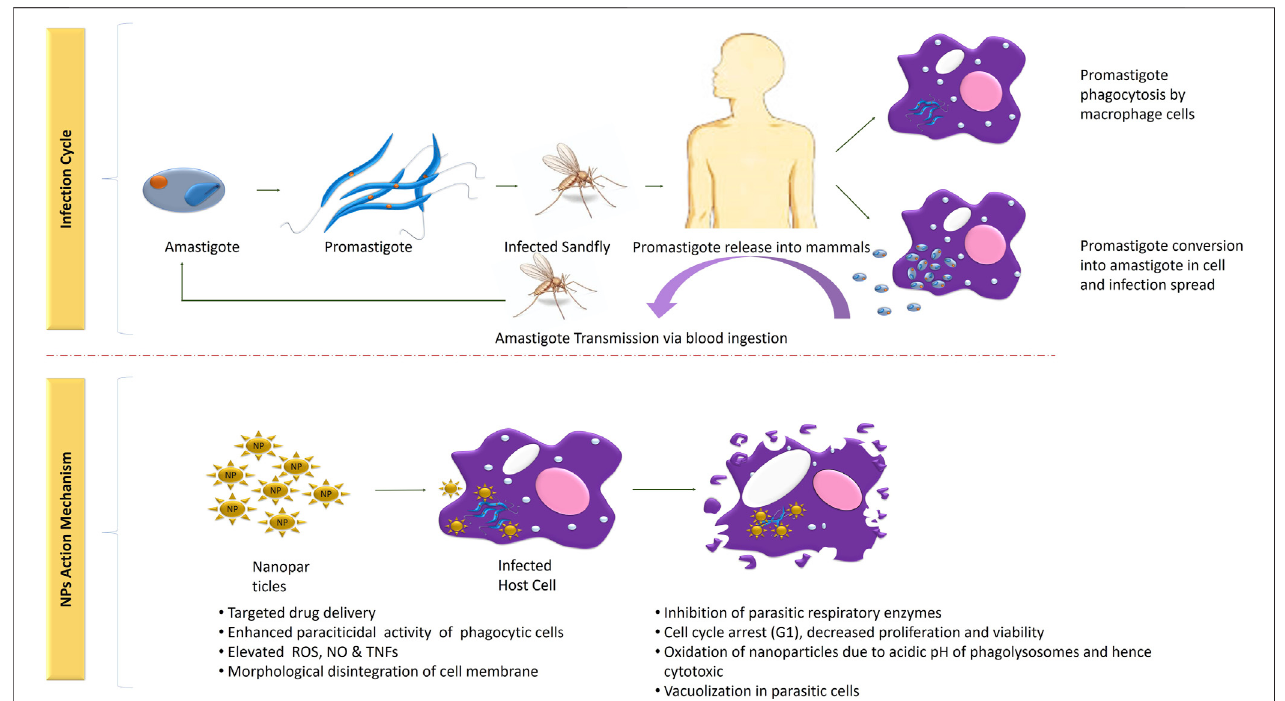
FIGURE 1 | Infection cycle and mechanism of action of NPs in the treatment of Leishmania .